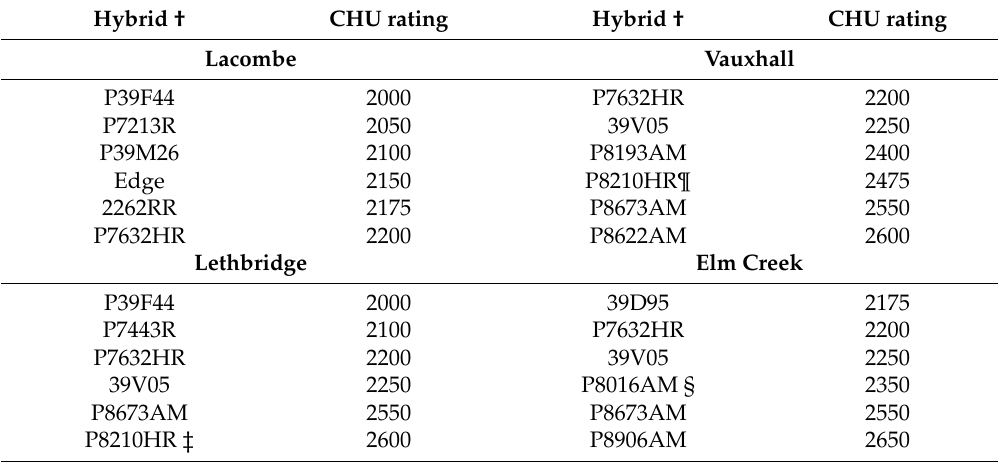
Table 2. Selected corn hybrids with grain maturity ratings for Lacombe, Lethbridge, and Vauxhall (Alberta) and Elm Creek (Manitoba) over three